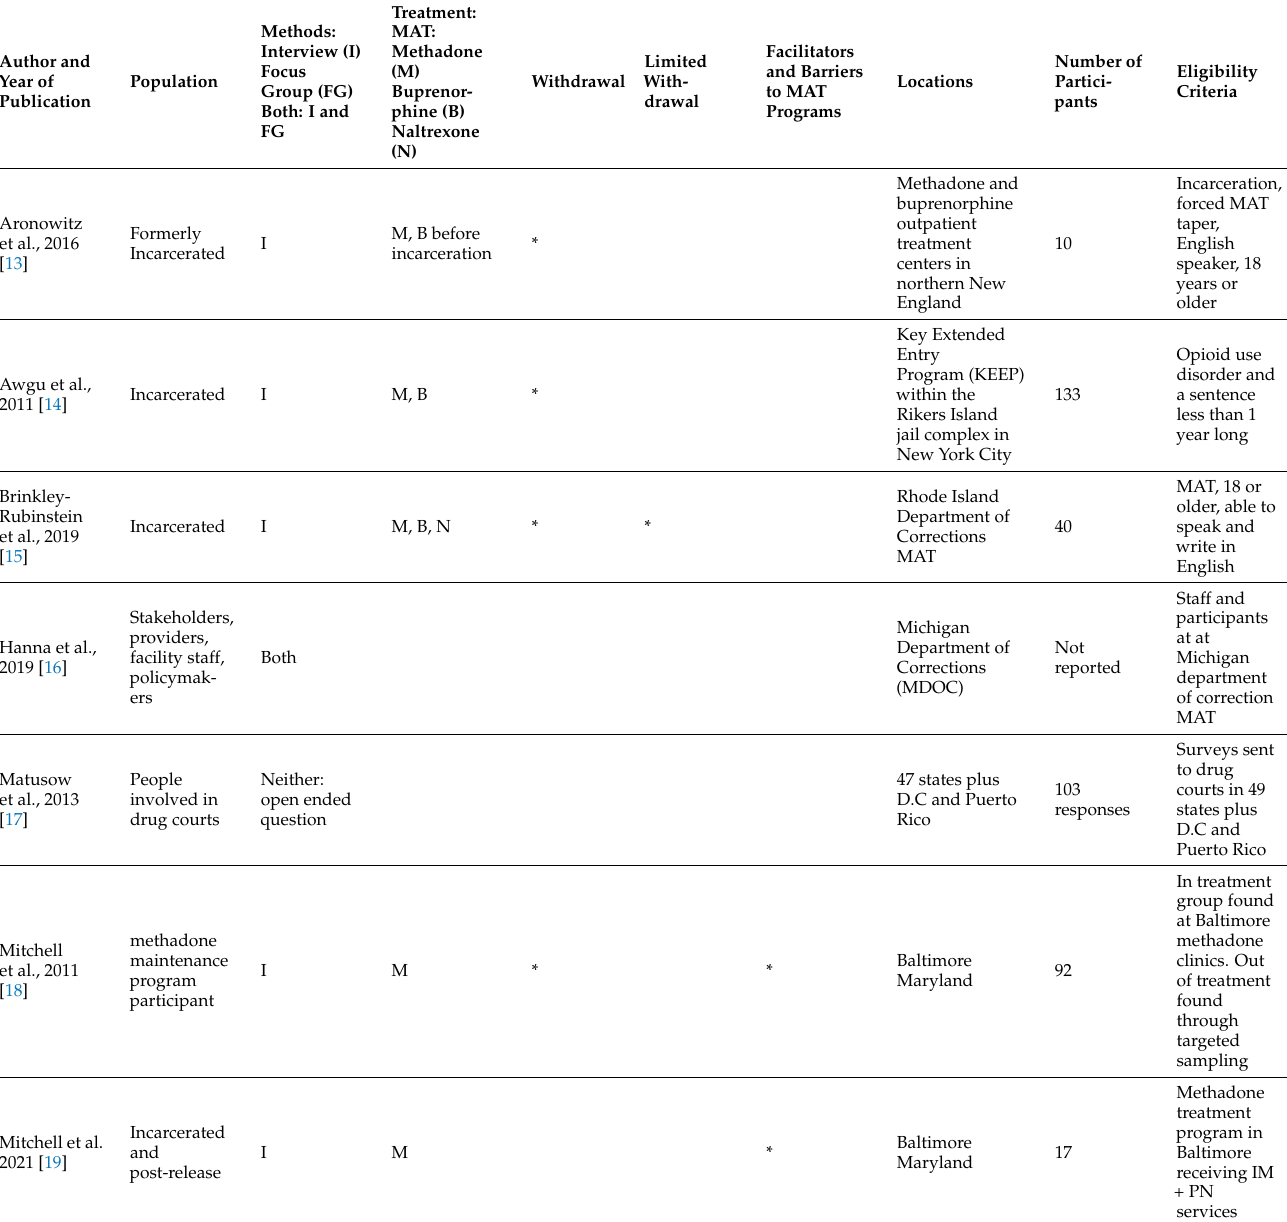
Table 1. Analysis of Eligible Qualitative Studies (n =